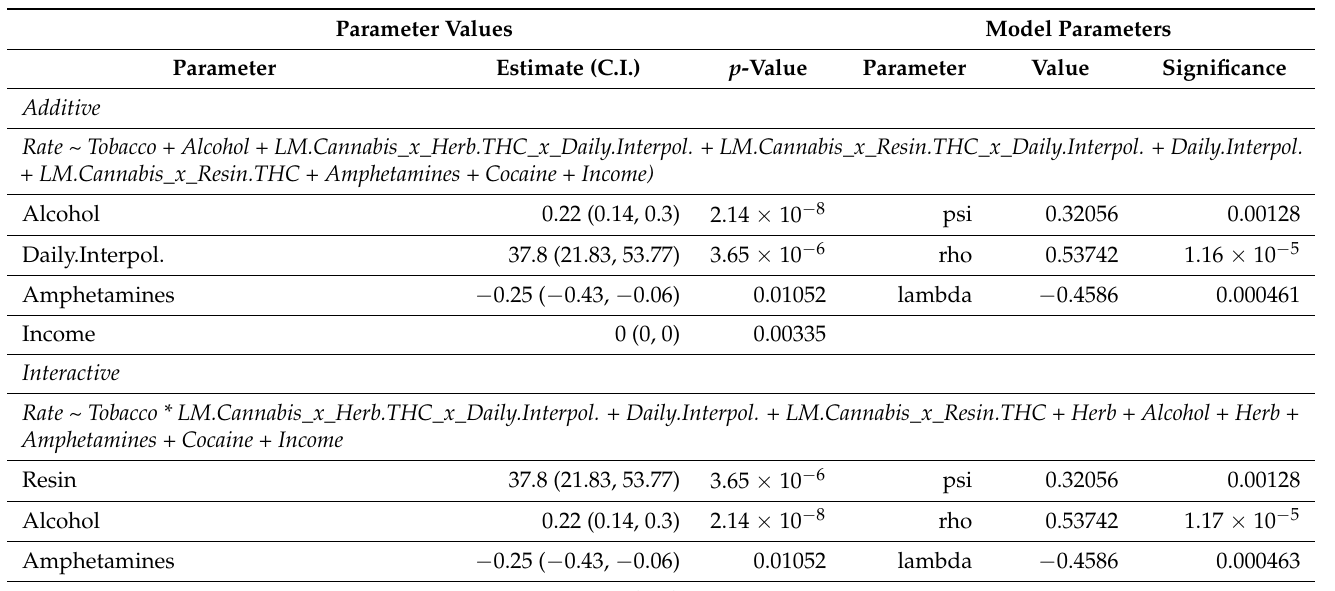
Table 3. Multivariate Geospatial Analysis for Severe